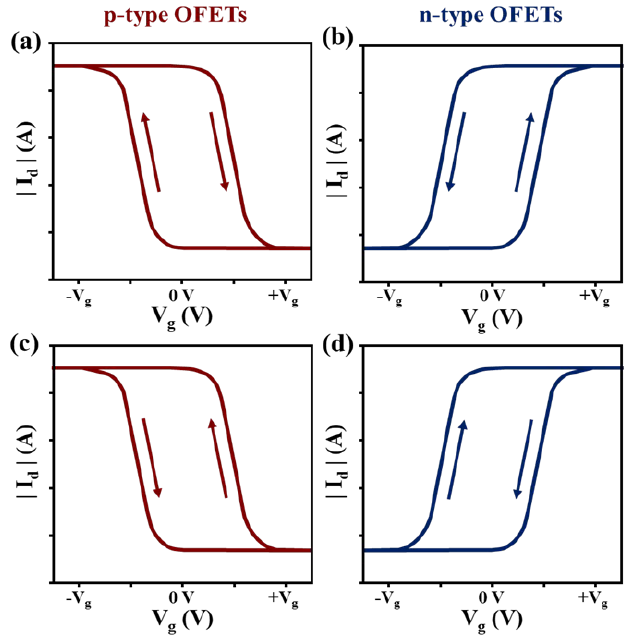
Figure 2. Example of transfer characteristics of p-type ( a , c ) and n-type ( b , d ) in OFETs. For each type, ( a , b ) depict higher back sweep current hysteresis whereas ( c , d ) show lower back sweep current